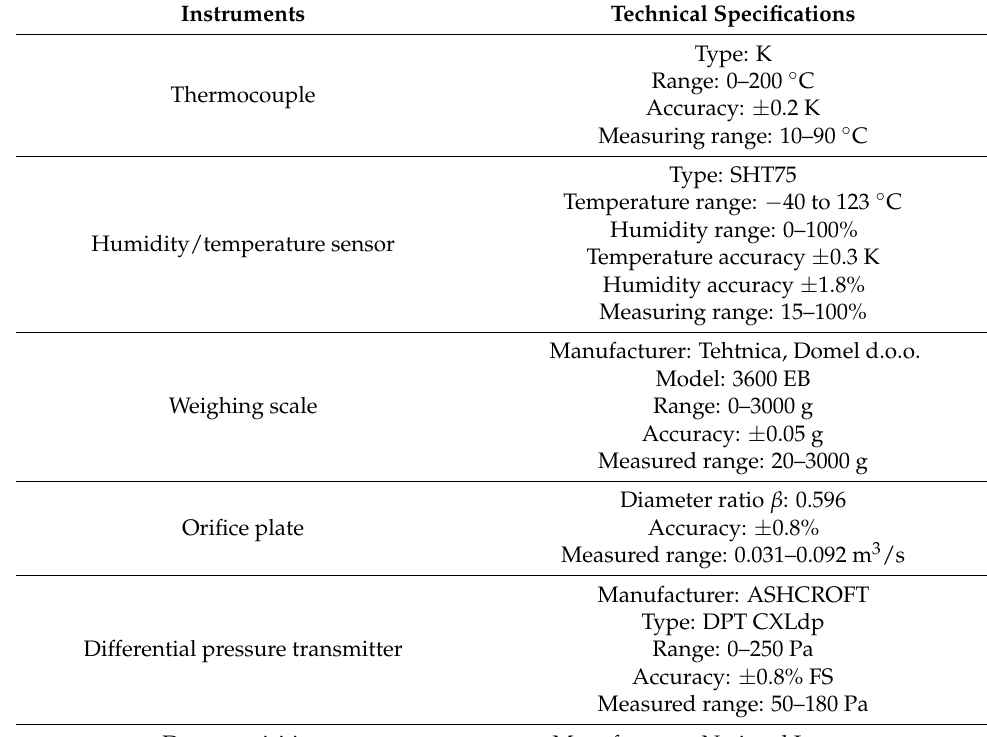
Table 1. Technical specifications of the measuring